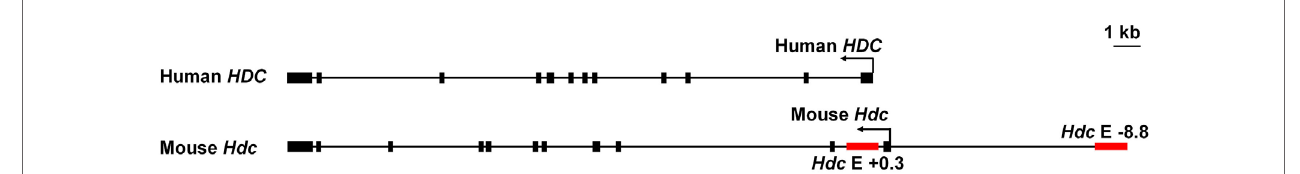
FigURe 3 | Genomic structures of the human and mouse histidine decarboxylase ( HDC ) gene. Red bars indicate the enhancers we